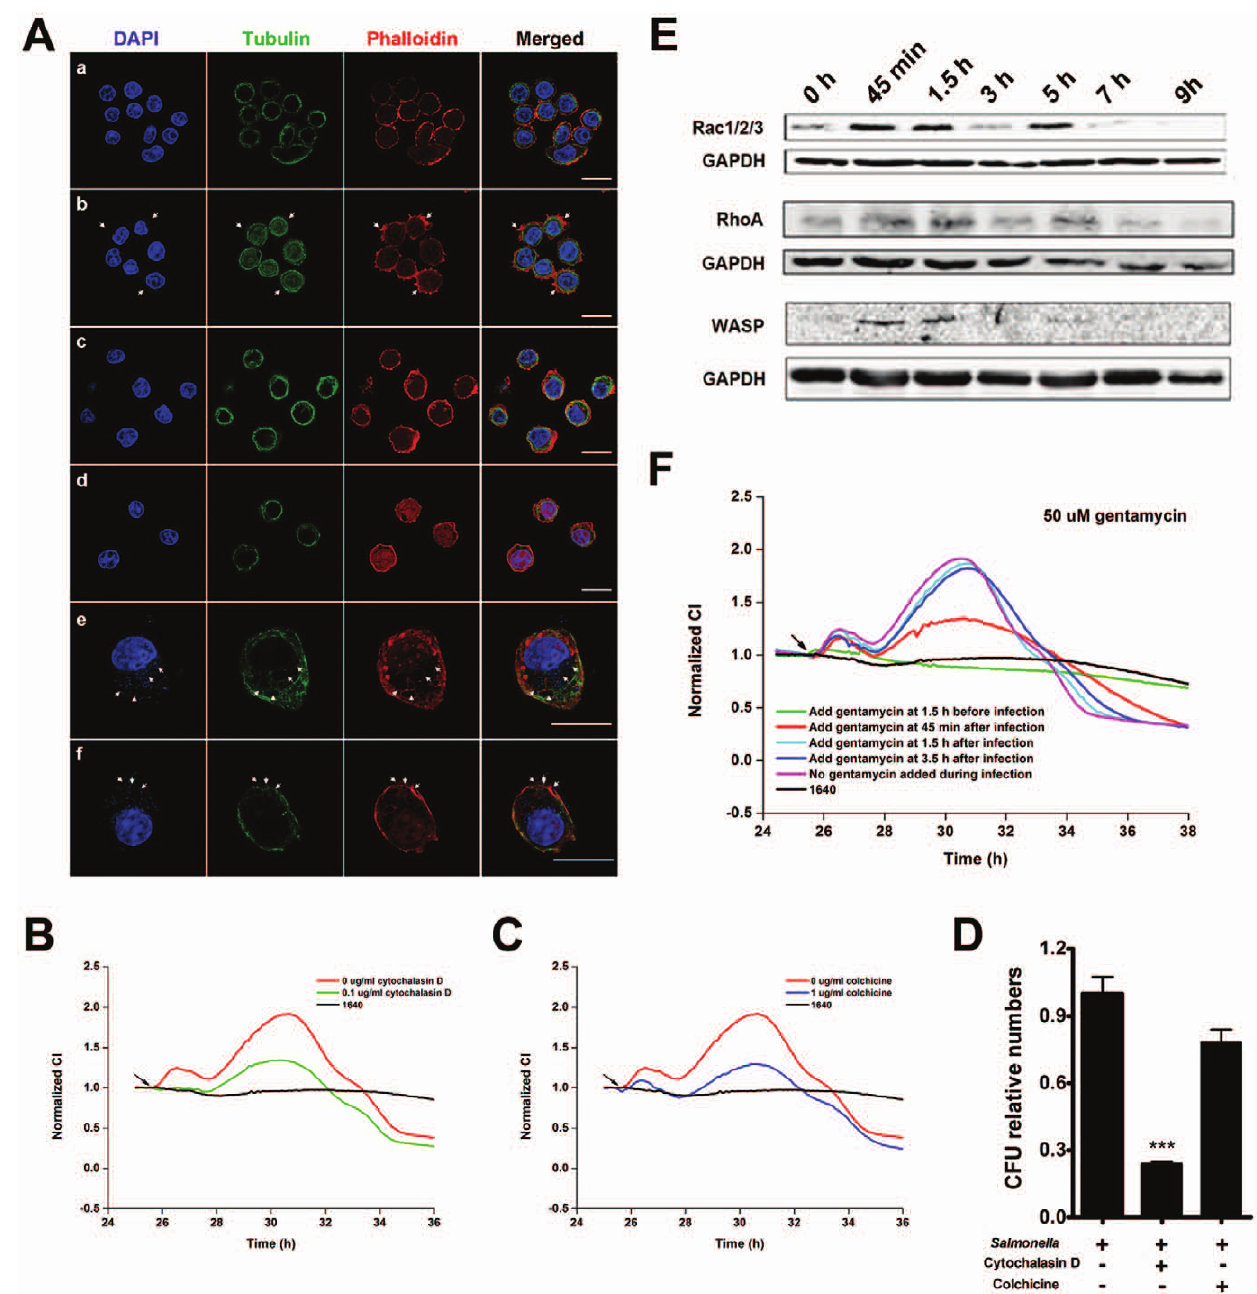
Figure 3. Correlation of Salmonella infection TCRP of intestinal cells and cytoskeleton-associated morphological dynamics. (A) Immunofluorescence images of HT-29 cells infected with S. typhimurium . (a) uninfected cells; (b) cells at 45 min post-infection. Actin-containing stress fibers are visible, as large accumulations of polymerized actin surrounding invading bacteria (arrows). (c and d) Cells at 1.5 h and 3 h post-infection. Actin cytoskeleton had normal architecture. (e) Cells at 5 h post-infection. Arrows, membrane ruffling and Salmonella-containing vacuoles (SCV). (f) Cells at 7 h post-infection. Arrows, membrane rupture and release of intracellular bacteria. (B) After pretreatment with cytochalasin D for 1.5 h, HT-29 cells were infected with S. typhimurium (MOI=200). (C) After pretreatment with colchicine for 1.5 h, HT-29 cells were infected with S. typhimurium (MOI=200). (D) HT-29 cells were pretreated with mock medium, cytochalasin D or colcocine for 1.5 h and infected with S. typhimurium at an MOI of 200. The number of invasive bacteria was determined by gentamycin protection assay. Data are mean 6 S.E.M with the number of intracellular bacteria in mock-treated cells set as 1.0. ***, p , 0.001 ( Student’s t -test). (E) Expression levels of cytoskeleton-associated proteins during Salmonella infection measured by western blotting. (F) Profiles of Salmonella infection after treatment of HT-29 cells with gentamycin (50 m g/ml) during infection. Arrows in B, C, F: bacterial addition points. Representative curves are an average of four replicate wells. doi:10.1371/journal.pone.0026544.g003 we used cytochalasin D, an inhibitor of actin filament polymer- inhibited the first peak and partially inhibited the second peak ization, and colchicine, a microtubule depolymerizing agen. At a induced by Salmonella infection (Figure 3B). In addition, the concentration that did not affect the CI, cytochalasin D completely number of invasive bacteria was significantly decreased after